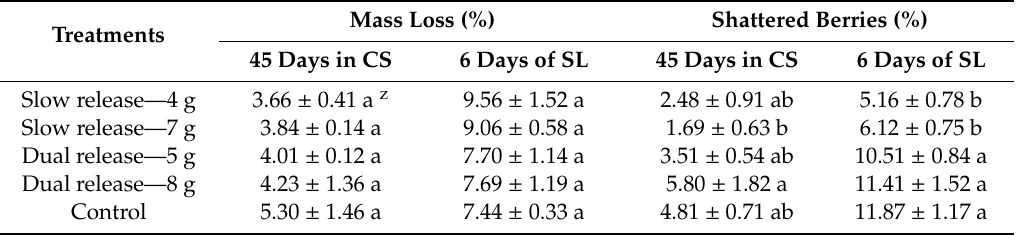
Table 2. Mass loss (%) and shattered berries (%) of clamshell-packaged ‘BRS Nubia’ seeded table grapes after 45 days of storage in cold storage (CS) at 1 ± 1 ◦ C followed by 6 days at shelf life (SL) at 22 ± 1 ◦ C, packaged with di ff erent SO 2 -generating pads.